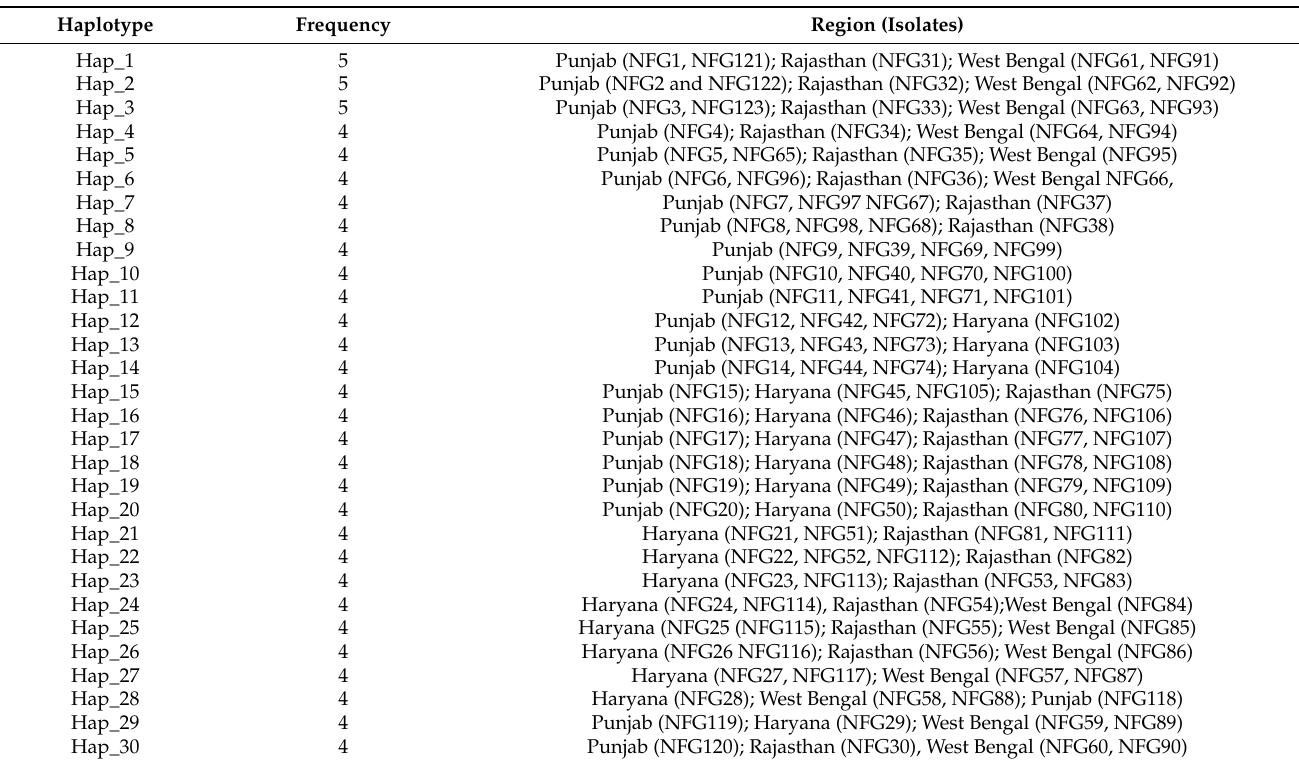
Haplotype diversity and nucleotide diversity are important indicators of population genetic variation. Haplotype and nucleotide diversities are generally considered to be low where haplotype diversity (Hd) and nucleotide diversity ( π ) are less than 0.5. Table 5. Haplotype frequency (Freq) and distribution for F. graminareum isolates based on combined gene